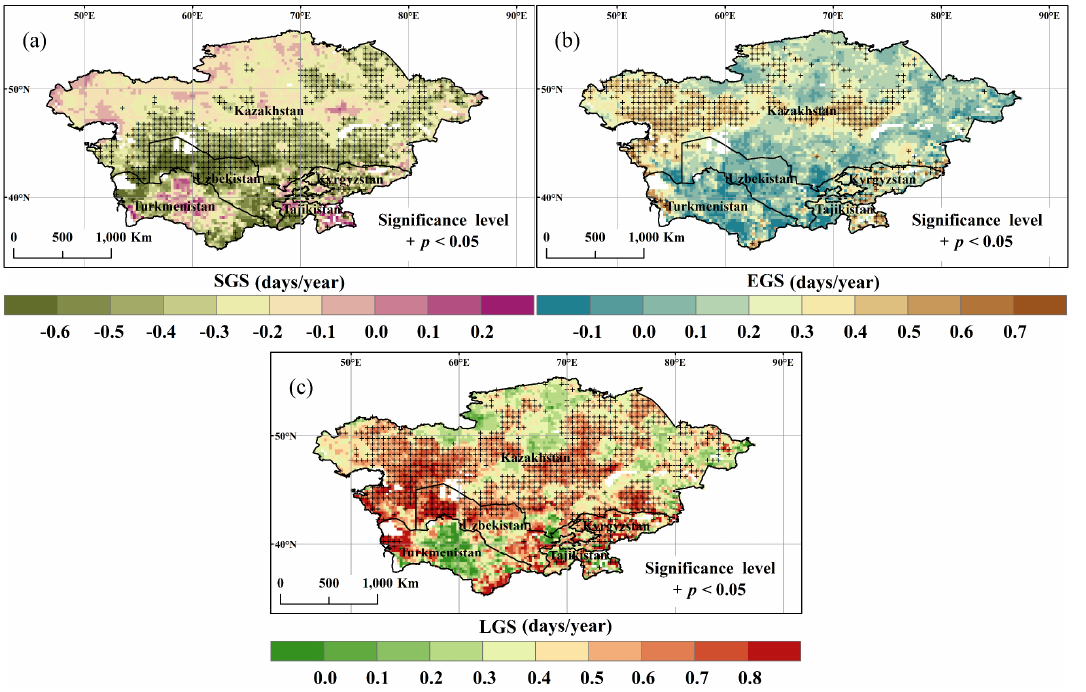
Figure 10. Spatial distribution of trends in ( a ) SGS, ( b ) EGS, and ( c ) LGS for the period 1982–2014. Temperature is one of the major drivers of vegetation phenology changes. Therefore, we analyzed the correlations between annual NDVI and three indicators of growing season (SGS, EGS, and LGS) derived from surface air temperature to identify the impact of growing season variability on vegetation dynamics (Figure 12). Over the whole study period, the regions showing a positive correlation between annual NDVI and SGS accounted for about 52.2% of the study area. Spatially, the greater positive correlation (>0.2) was occurred mainly in the center of the study area, while the larger negative correlation (< − 0.2) was primarily recorded in the north and southeast. Meanwhile, approximately 52.2% of the study area experienced a positive correlation between annual NDVI and EGS, and a larger positive correlation (>0.2) was observed mostly in the south. Then, we analyzed the correlation between annual NDVI and LGS and found that a negative correlation represented approximately 53.6% of the study area. Spatially, the greater negative correlation (< − 0.2) between annual NDVI and LGS was mainly found in the central, and the larger positive correlation (>0.2) was mainly in the